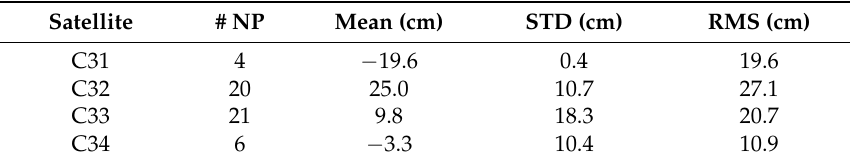
Table 6. SLR residuals for BDS-3 satellites C31, C32, C33, and C34.